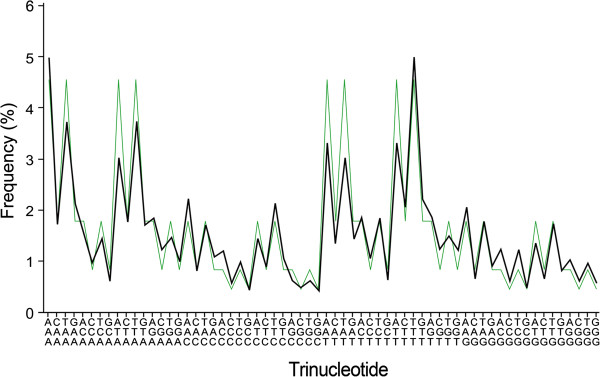
Common profile 1 for genomic trinucleotide frequencies and the average profile of its corresponding random sequences. Common profile 1 (black line) was obtained as the average of similar trinucleotide frequency profiles of 184 prokaryotic genomes (chromosomes) with GC content ranging from 16.56% to 42.83%. Alongside common profile 1 is the average trinucleotide frequency profile (green line) of 140 random sequences with GC content of 16%–43% and generated according to first-order symmetry. Trinucleotides in abscissa should be read vertically from bottom to top.